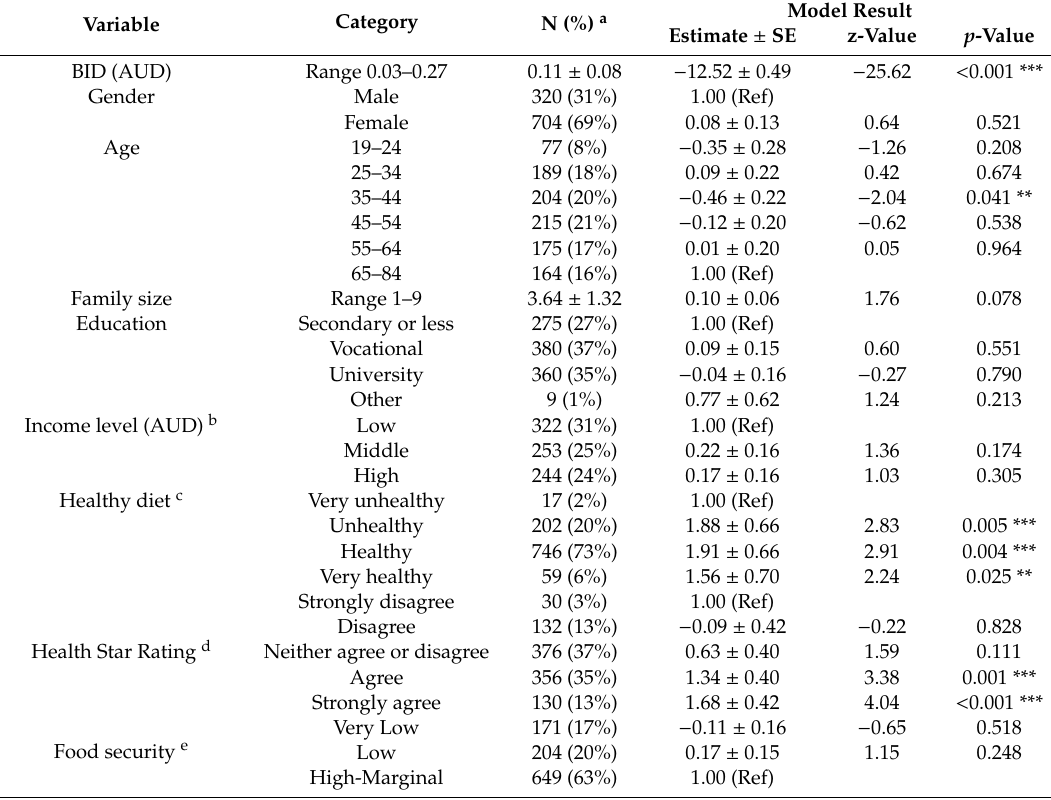
Table 2. Parameter estimates of the willingness to pay